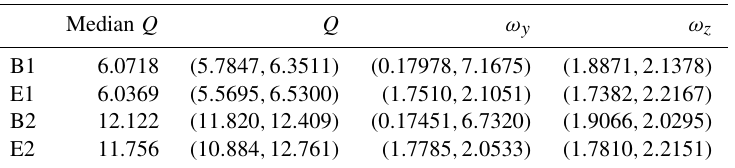
Table 2. Posterior median emission rates in grams per minute (gmin − 1 ), and the posterior 95% credible intervals of the emission rate in grams per minute, ω y , and ω z from the OSSE. Results shown are from simulated data corresponding to the Boreal lasers (B) and EC towers (E) when the emission rate is 6gmin − 1 (E1 and B1) and 12gmin − 1 (E2 and B2).